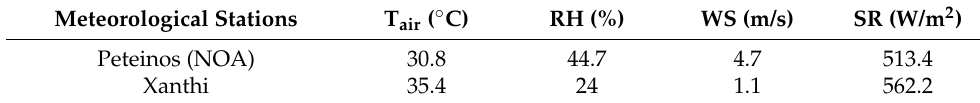
Table 7. Average value of microclimatic data (16 July 2016 to 6 August 2016).